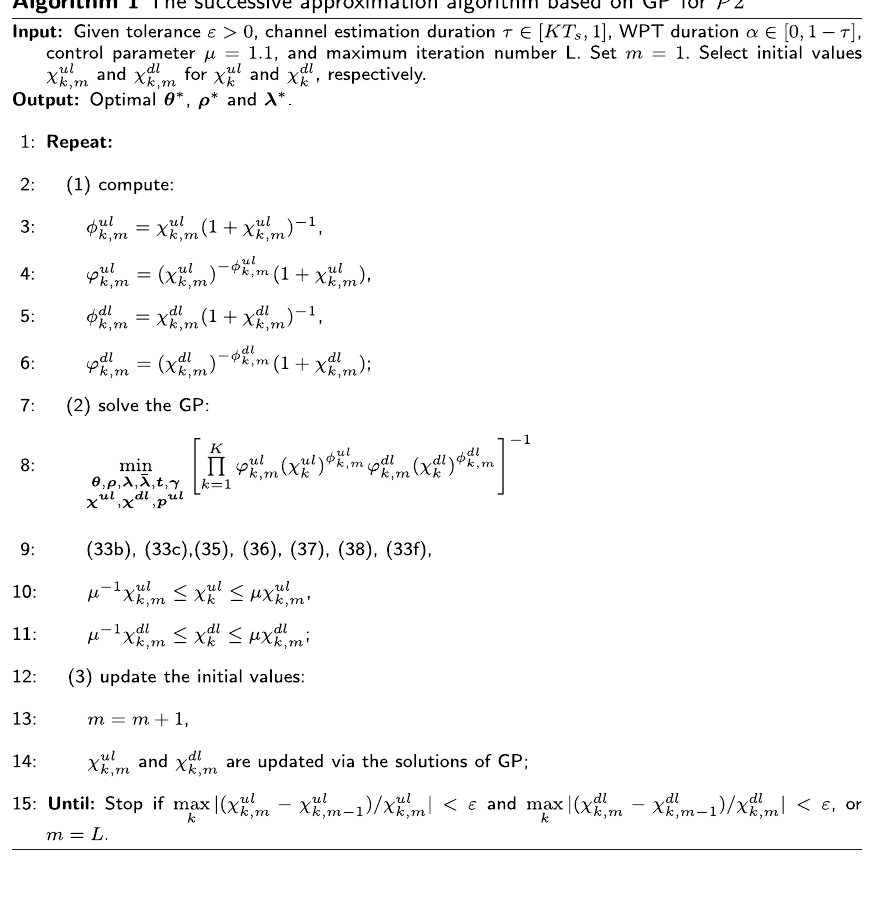
The parameter µ is used to control approximation accuracy and is set to be 1.1 in most practical cases [31] and the convergence of Algorithm 1 is also guaranteed